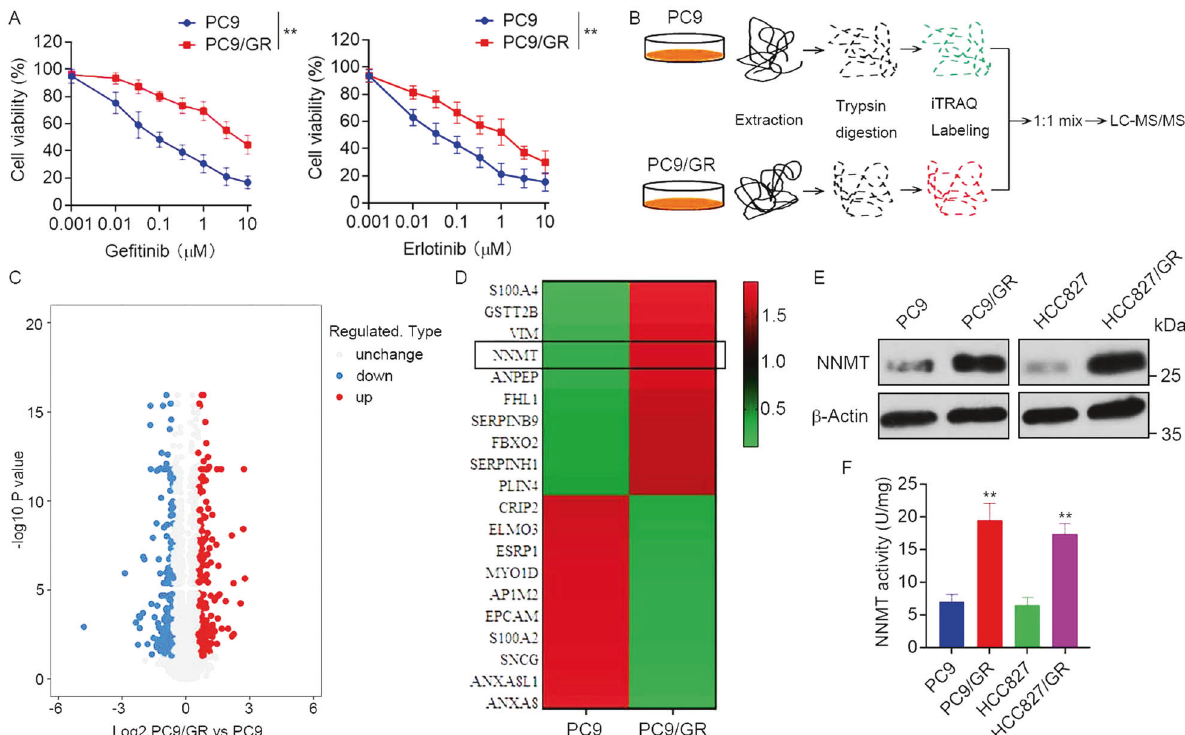
Fig. 1 Upregulation of NNMT in EGFR-TKI-resistant NSCLC cells. A EGFR-TKI-resistant PC9/GR and parental PC9 cells were treated with ge fi tinib or erlotinib at the indicated concentration for 72 h, cell viability was evaluated by MTS assay. B iTRAQ-based quantitative proteomic comparison of PC9/GR cells and PC9 cells, experimental work fl ow showing the trypsin digestion, iTRAQ-labeling, and detection by tandem mass spectrometry. The acquired data was used to search a bioinformatics database. C Volcano plot showing the log 2 fold-change and signi fi cance ( − log 10 p -value) of the proteome dataset. Red dots represent signi fi cantly upregulated proteins, blue dots represent signi fi cantly downregulated proteins. D Hierarchical clustering of top 20 differentially expressed proteins. E Validation of NNMT expression in EGFR-TKI- resistant PC9/GR, HCC827/GR, and parental PC9, HCC827 cells by Western blot. F NNMT speci fi c activity in PC9/GR, HCC827/GR, PC9, and HCC827 cells was tested by measuring the amount of N 1 -methylnicotinamide produced. Each point represents the mean ± SD. Data show a representative of three independent experiments. (** p <